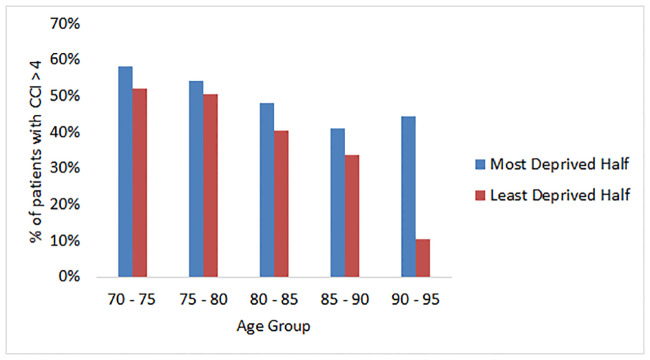
Distribution of patients by age, poverty and higher comorbidity.